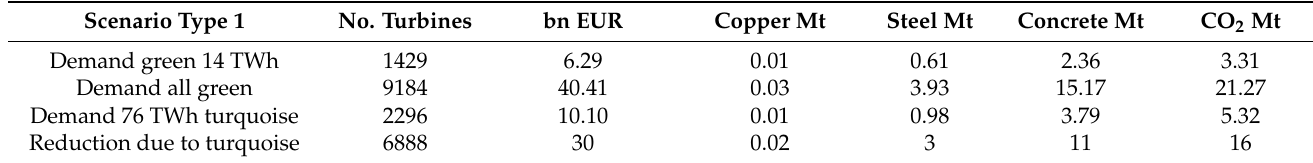
Table 3. Costs of green and turquoise hydrogen for type 1 onshore turbines.